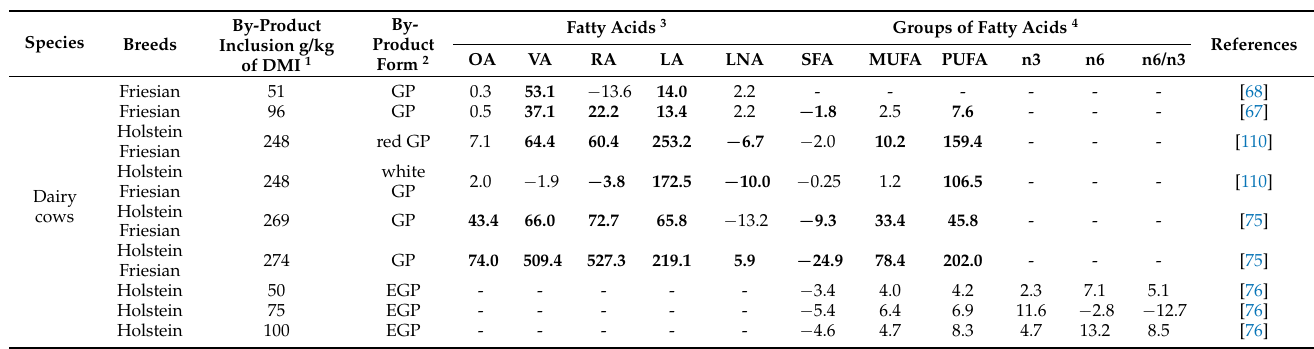
Table 3. Effect of grape by-products included in dairy ruminants’ diets on milk content of oleic acid (OA), vaccenic acid (VA), rumenic acid (RA), linoleic acid (LA), and alpha-linolenic acid (LNA) and saturated (SFA), monounsaturated (MUFA), and polyunsaturated (PUFA) fatty acids. Data are reported as the proportional difference between the treatment group, at the respective level of inclusion, and the control